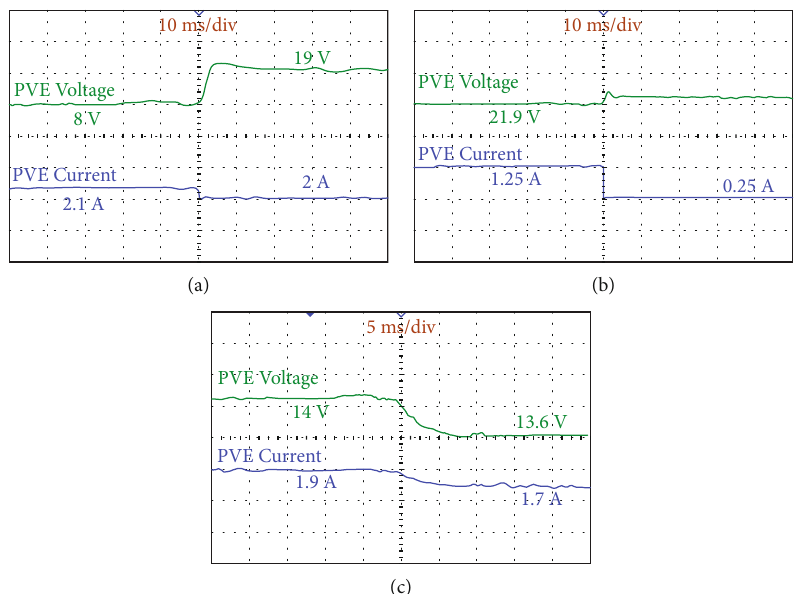
Figure 18: Transient performance of the proposed PVE for load change near (a) constant current, (b) constant voltage regions, and (c) for change in ratio of partial